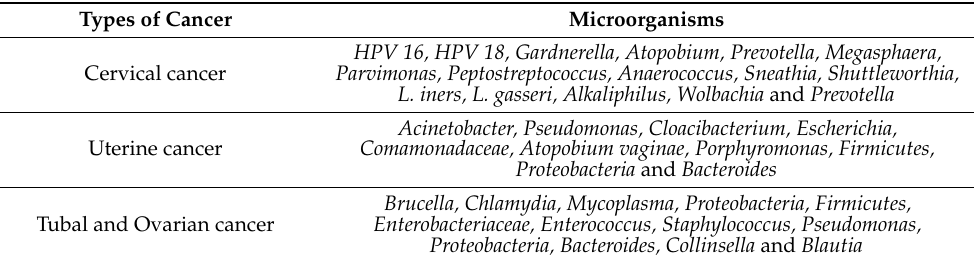
Table 1. Microrganisms in gynaecologic cancers.